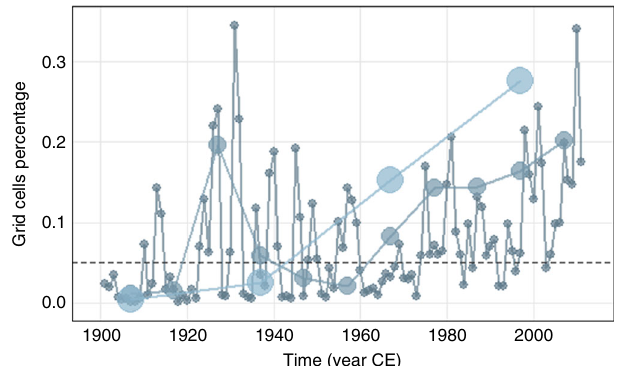
Fig. 4 Cross-scale examination of recent pluvial. Grid cell percentage above the 0.95 quantile at 1-, 10-, and 30-year scales since 1900. Grey dashed line represents the theoretical quantile